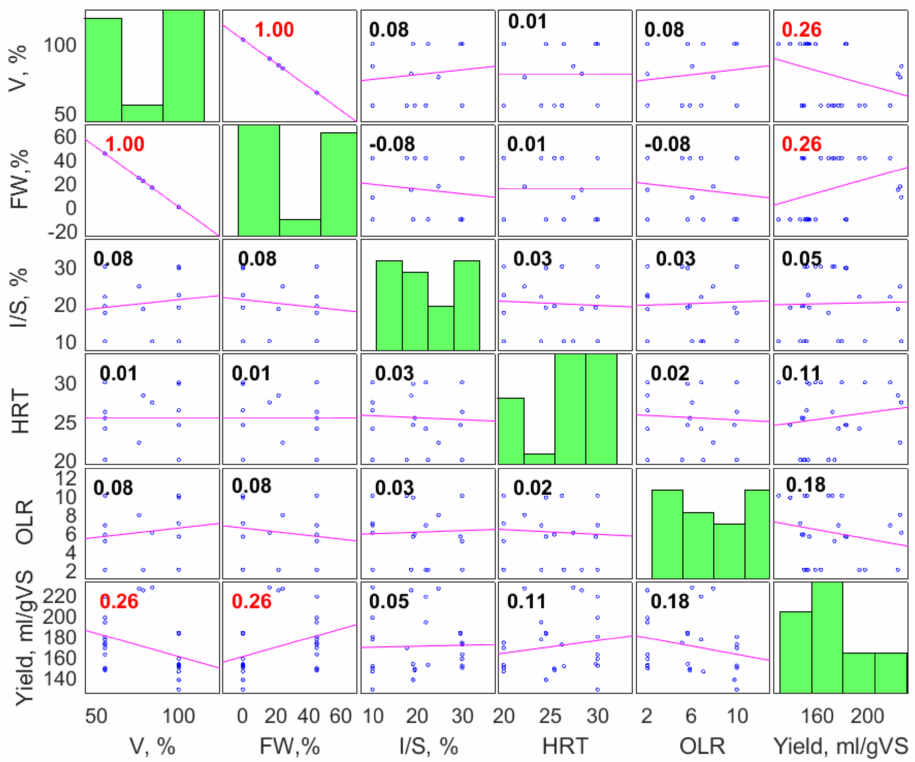
Figure 4. Kendall’s rank of